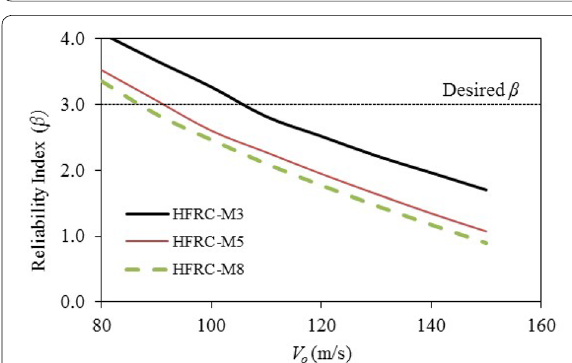
Fig. 7 Variation of reliability index of HFRC specimens with impact velocity.